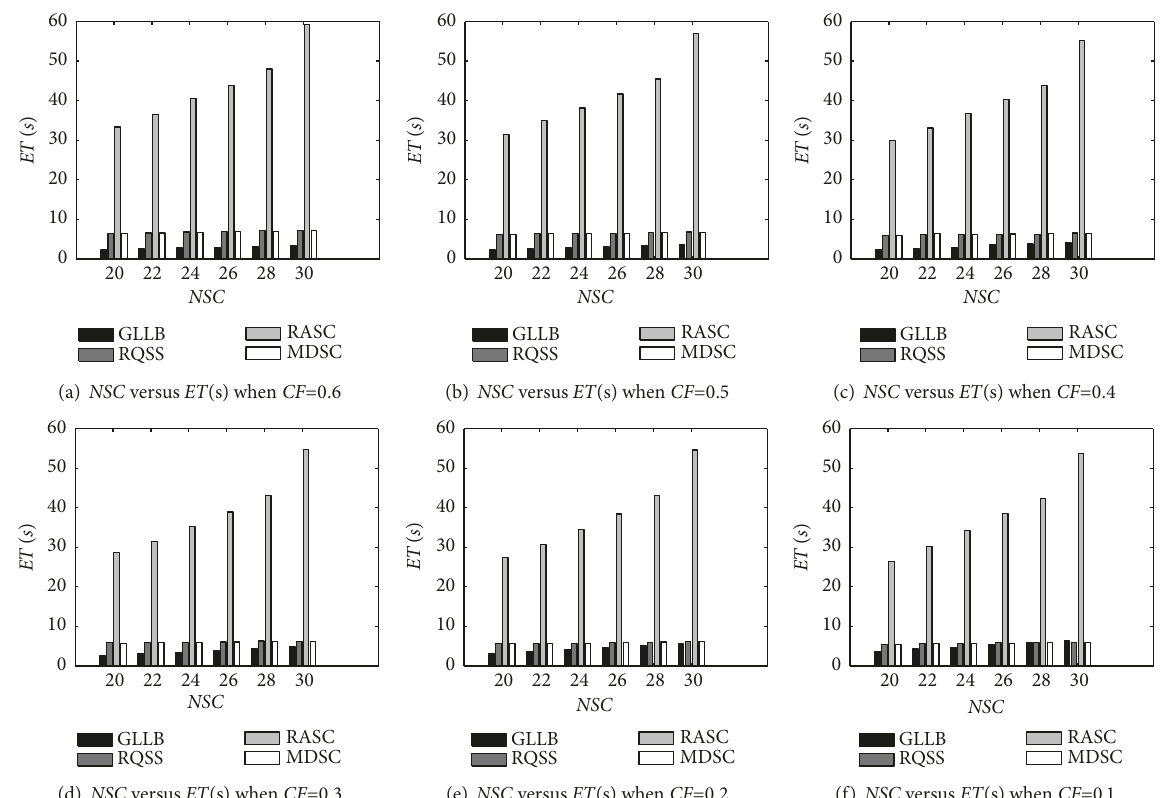
Figure 3: The execution time of different